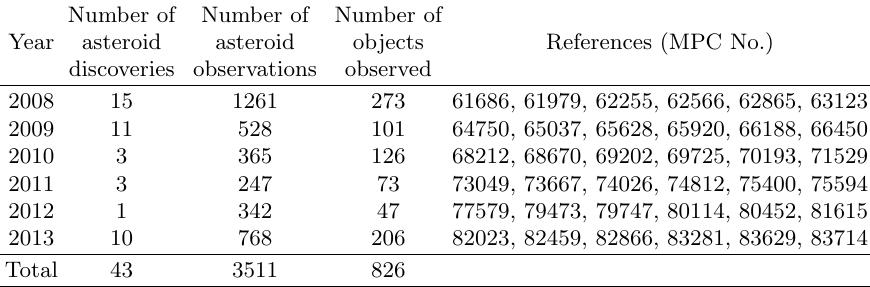
Table 1. Distribution of asteroid discoveries at the Baldone Observatory by year and the numbers of astrometric observations of newly and previously discovered asteroids.